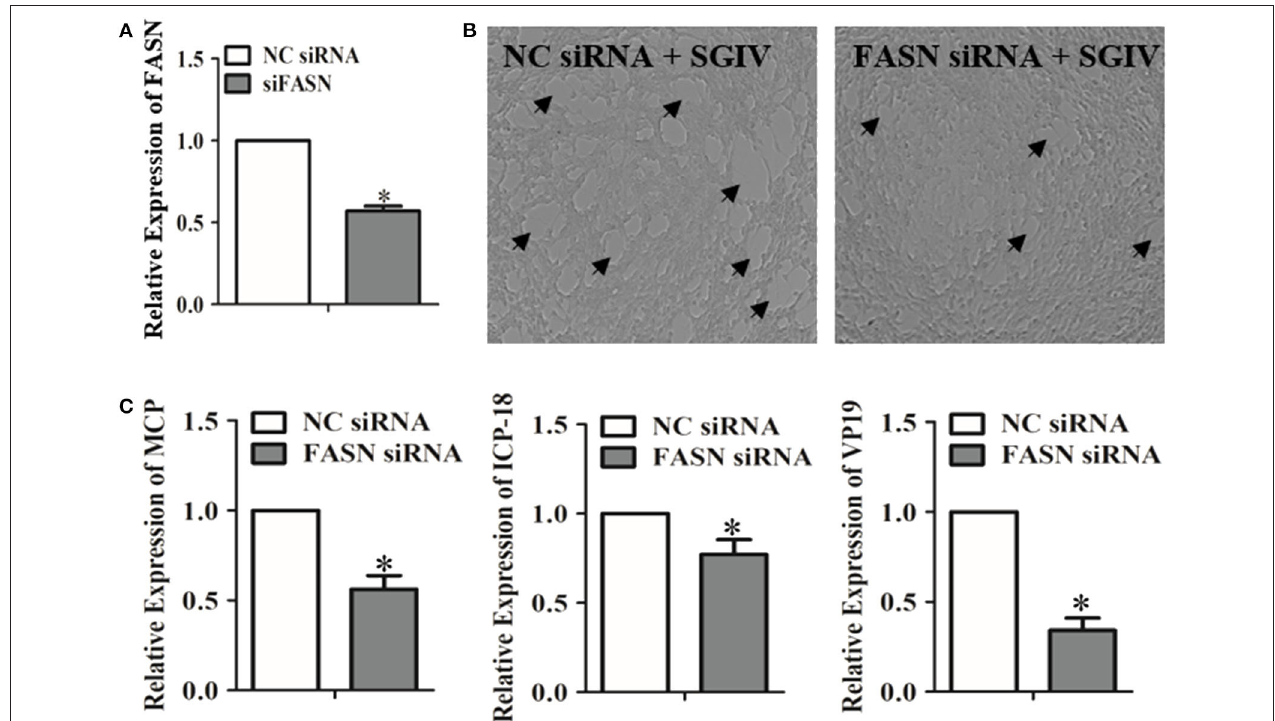
FIGURE 2 | Evaluation of the impacts of the FASN gene knockdown on SGIV replication. (A) The interfering efficiency of the FASN gene in GS cells was analyzed by qRT-PCR. (B) GS cells were transfected with negative control (NC) siRNA or FASN siRNA. Cells were infected with SGIV subsequently. The cytopathic effects of SGIV infection were observed. (C) The mRNA transcriptional levels of SGIV functional genes were evaluated in NC siRNA or FASN siRNA transfected cells. The data are represented as mean ± SD, and the statistical significances were determined with Student’s t -test, n = 3. The significance level was defined as * p <